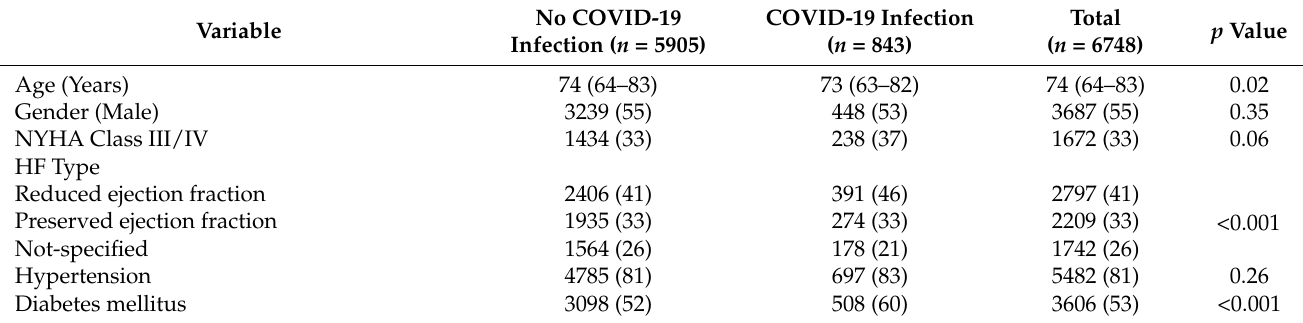
Table 1. Demographics and clinical characteristics of patients with heart failure according to COVID-19 infection.